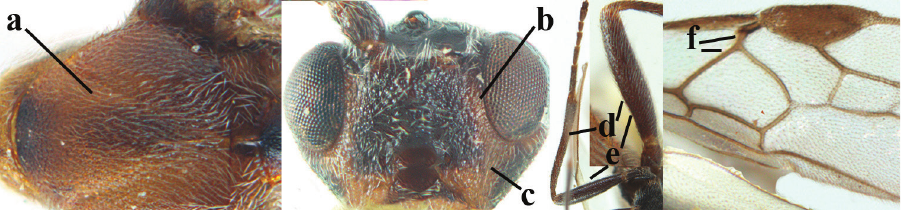
Mesoscutum (aa), orbita (bb) and malar space (cc) black; all femora and tib- iae reddish or yellowish brown (dd); fore and hind femora less slender (ee); vein 1-SR of fore wing sublinear with vein 1-M (ff) .................................. 17